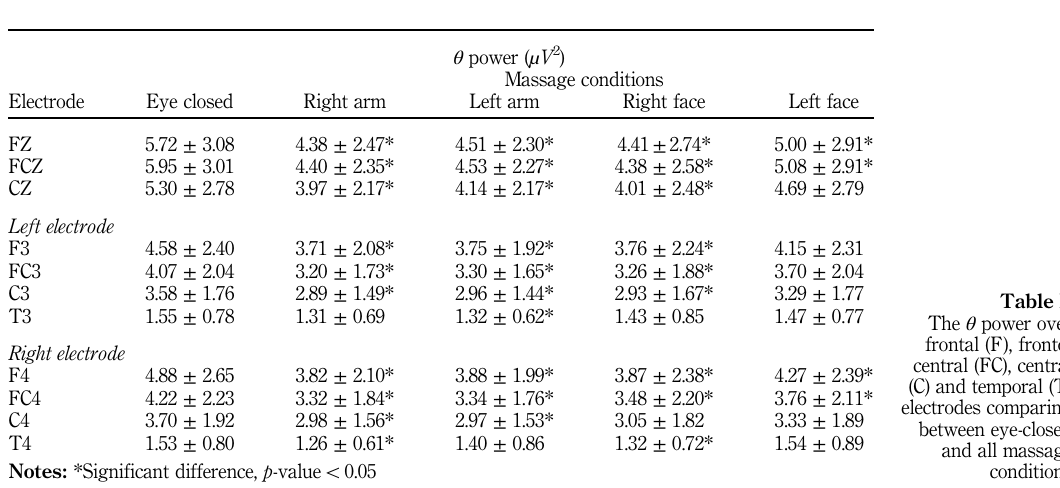
Figure 3. The topographic brain mapping of θ power during eye-closed (baseline), left-arm and right-arm massage conditions